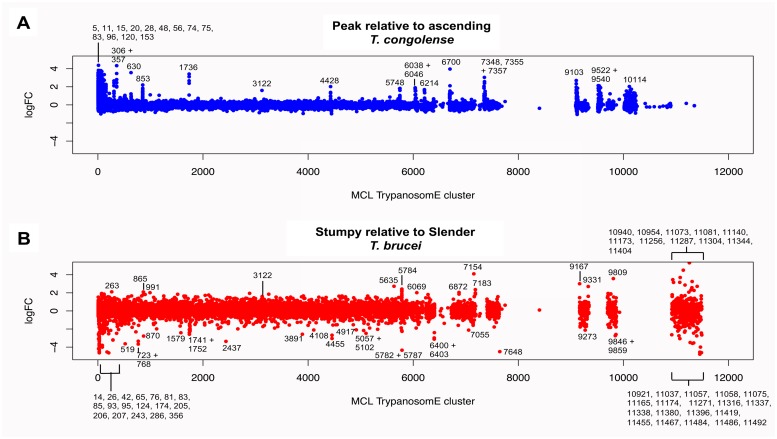
Differential orthogroup expression in T. congolense and T. brucei.(A.) Log2 fold change between peak and ascending parasitaemia T. congolense of all transcripts aligned according to their MCL TrypanosomE orthologous grouping. Groups that show Log2FC of 2 or more in at least one member are annotated. (B.) Log2 fold change between stumpy and slender form T. brucei of all transcripts aligned according to their MCL TrypanosomE orthologous grouping. Groups that show Log2FC of 2 or more in at least one member are annotated.